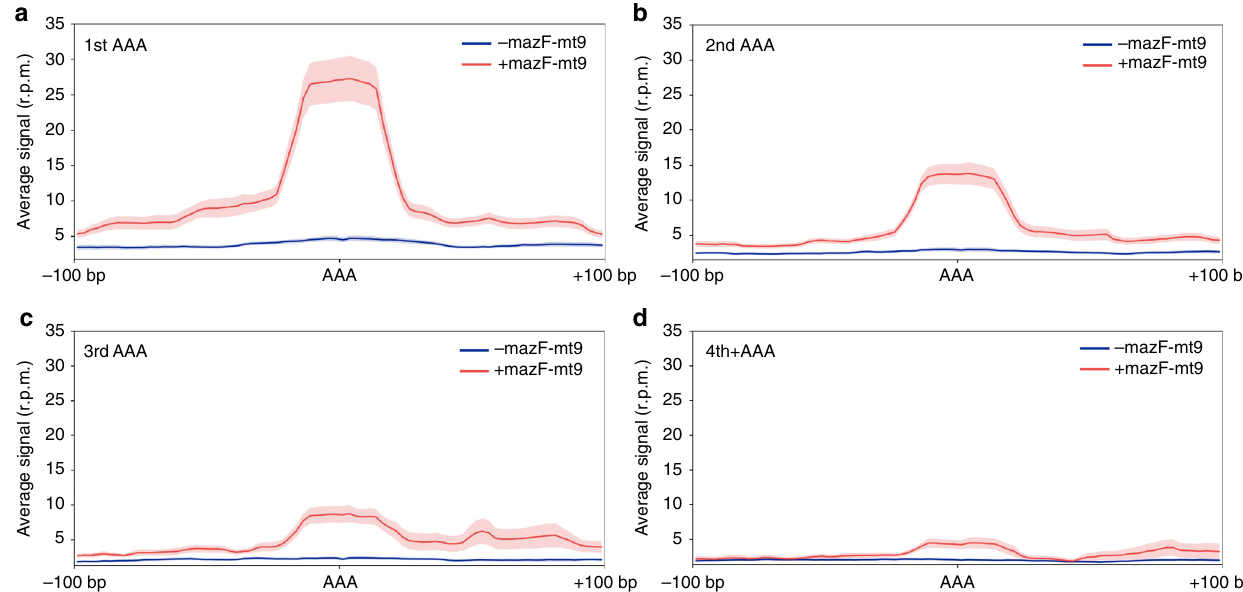
Fig. 4 Ribo-seq shows ribosome stalling preference for early AAA codons. a – d Average read counts (reads per million, rpm) of mapped ribosome footprints surrounding the fi rst ( a ), second ( b ), third ( c ), or fourth and higher ( d ) AAA Lys codon of M. smegmatis genes. Blue or red solid line represents uninduced cells or cells expressing MazF-mt9, respectively, with the light-colored shading denoting standard